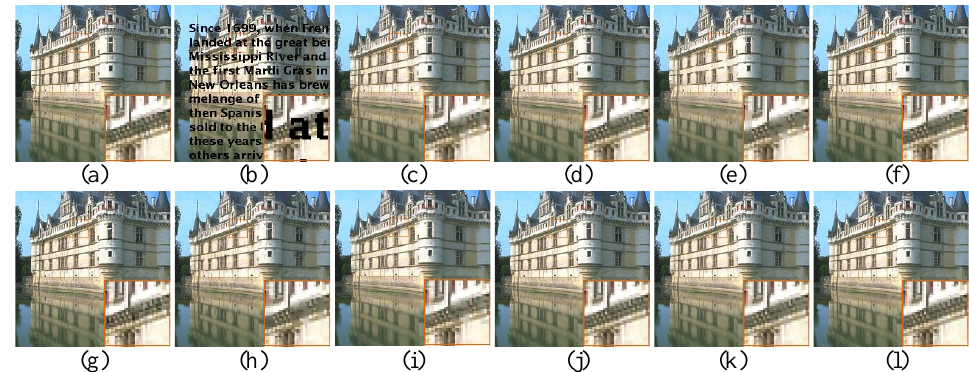
Figure 4. Visual comparison of Tower by image inpainting with text inlayed. ( a ) Original image; ( b ) Degraded image with 80% pixels missing; ( c ) BPFA [64] (PSNR = 30.94 dB, SSIM = 0.9530); ( d